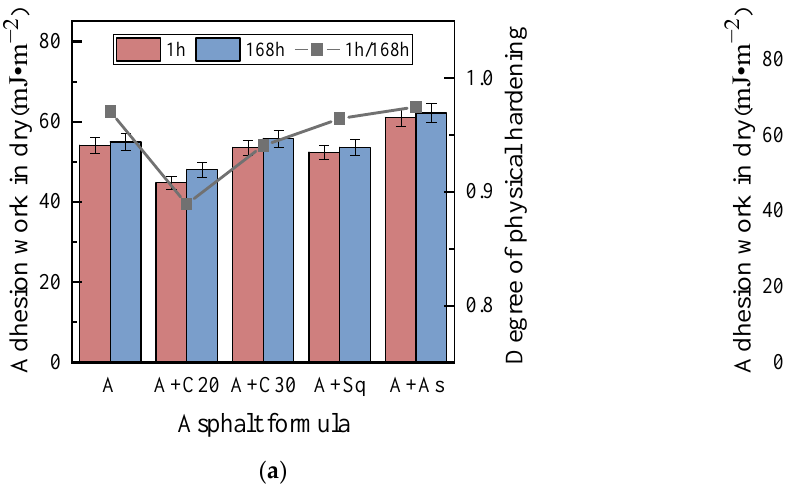
Figure 10. Adhesion work in dry conditions. ( a ) Asphalt A. ( b ) Asphalt B.